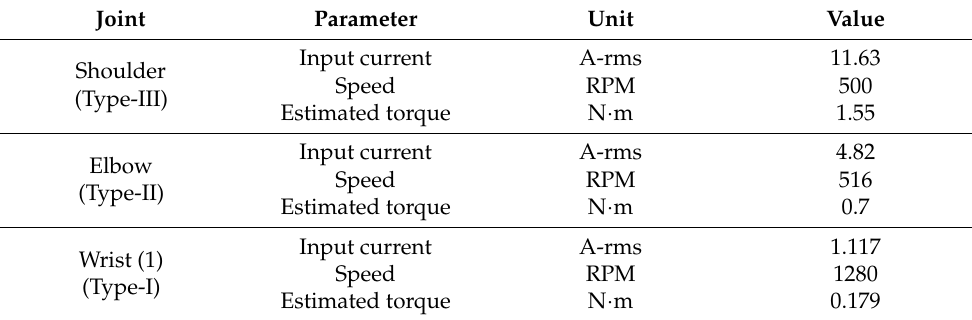
Table 9. Estimated Torque of Joint Motors.